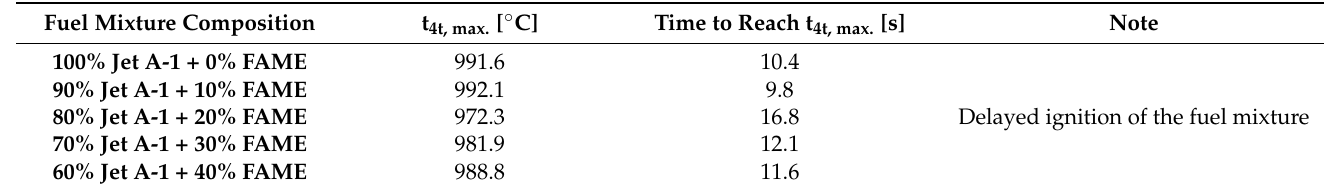
Table 18. Change in the maximum total gas temperature behind the gas turbine t 4t , max. [ ◦ C] SJE-20 with different concentrations of Jet A-1 aviation kerosene and FAME biofuel.